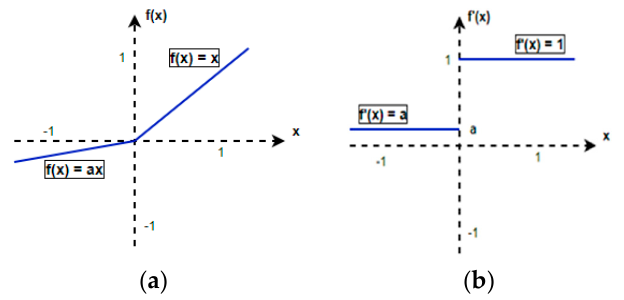
Figure 8. ( a ) Parametric ReLU (PReLU) activation function; ( b ) Derivative of the PReLU.